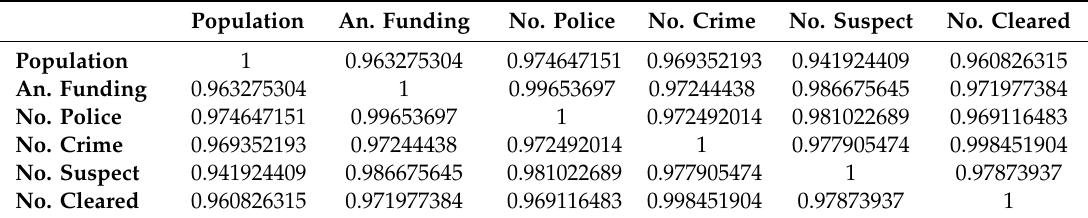
Table 3. Correlation coe ffi cient